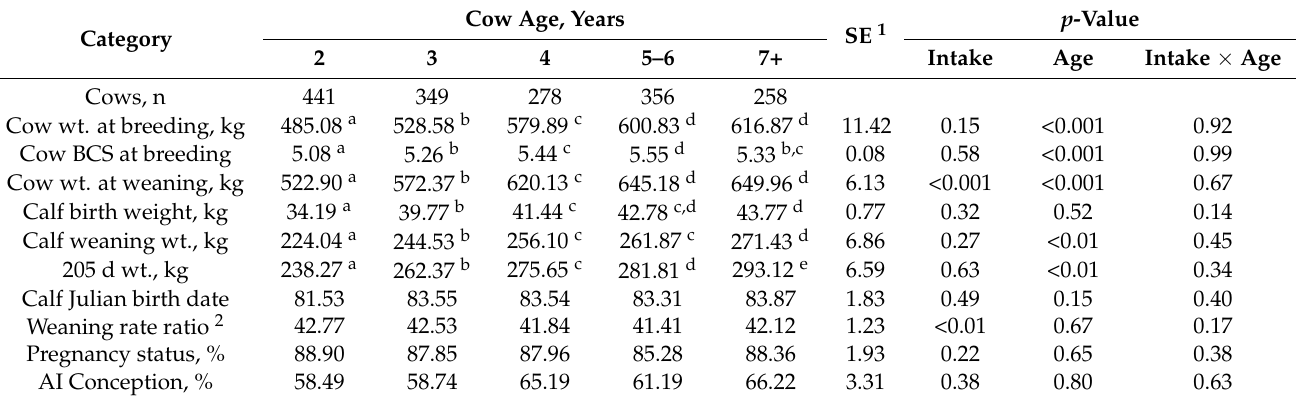
Table 3. The influence of cow age on production and longevity characteristics in Angus beef